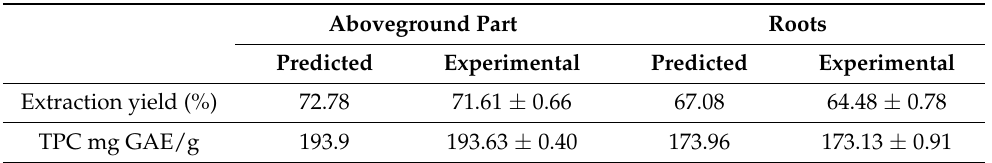
Table 4. Validation of the proposed models describing the extraction yield and TPC for the above- ground part and roots, based on triplicate extractions. Aboveground Part Roots Predicted Experimental Predicted Experimental Extraction yield (%)